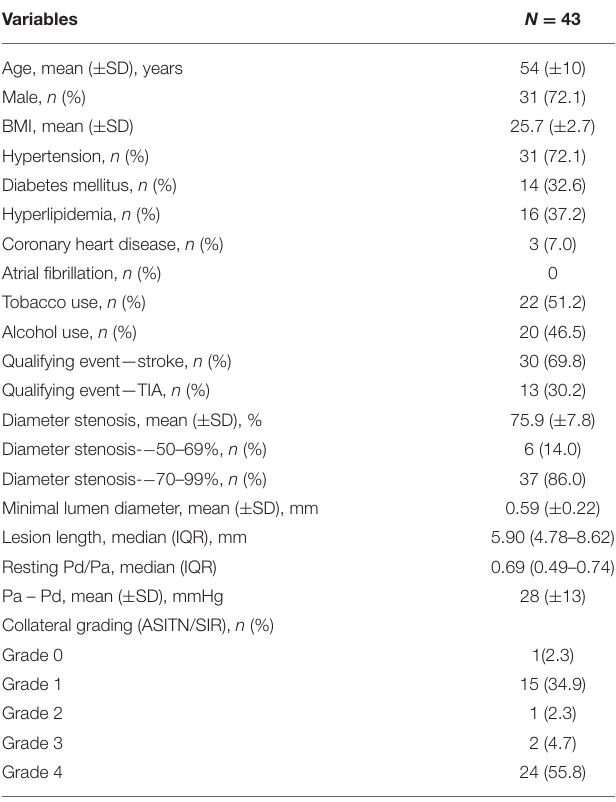
TABLE 1 | Clinical characteristics and lesion